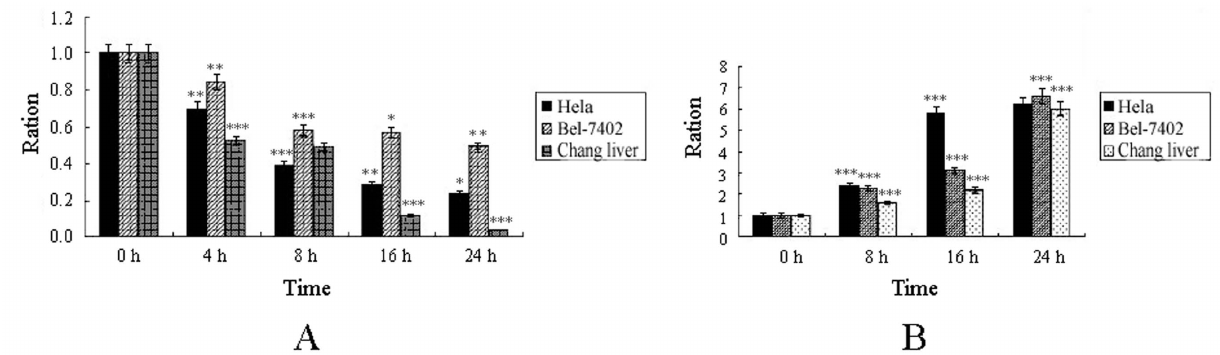
Figure 2. Intracellular redox level under T-2 toxin. A. Level of endogenous GSH under T-2 toxin stress. B. Levels of endogenous MDA under T-2 toxin stress. Data was presented as mean 6 SD. *p , 0.05, **p , 0.01, ***p , 0.001.